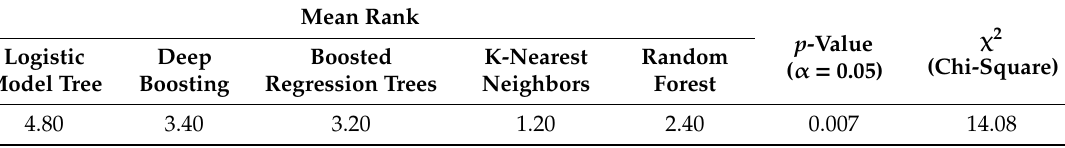
Table 4. Comparison of the five MLAs using the Friedman